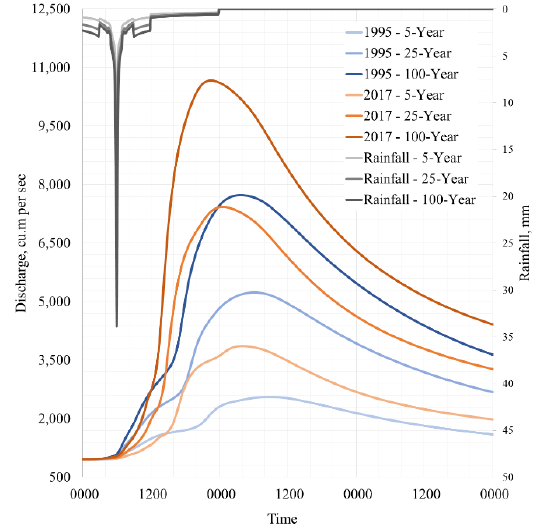
Figure 3. Discharge hydrographs computed by the HEC HMS models at Dankias Station for the two land cover conditions under three extreme rainfall scenarios.